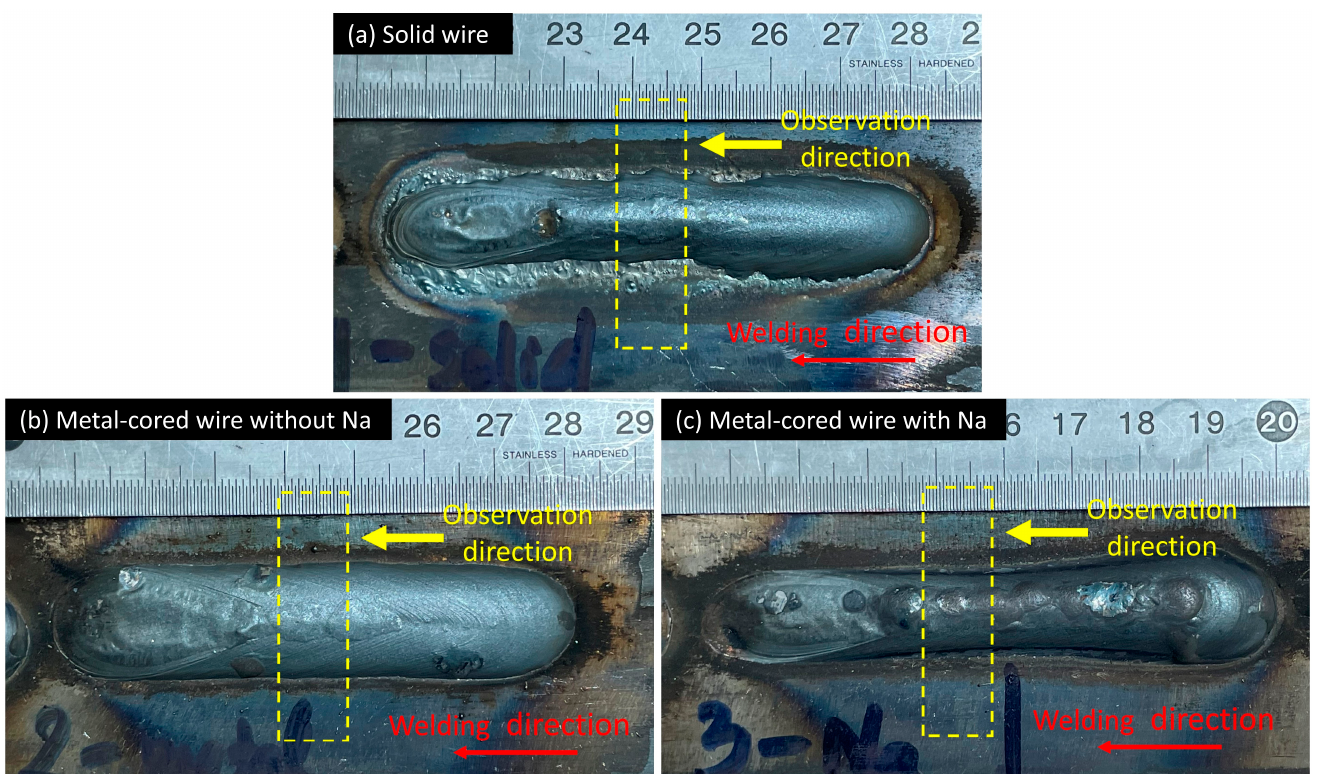
Figure 10. The photo of the weld bead